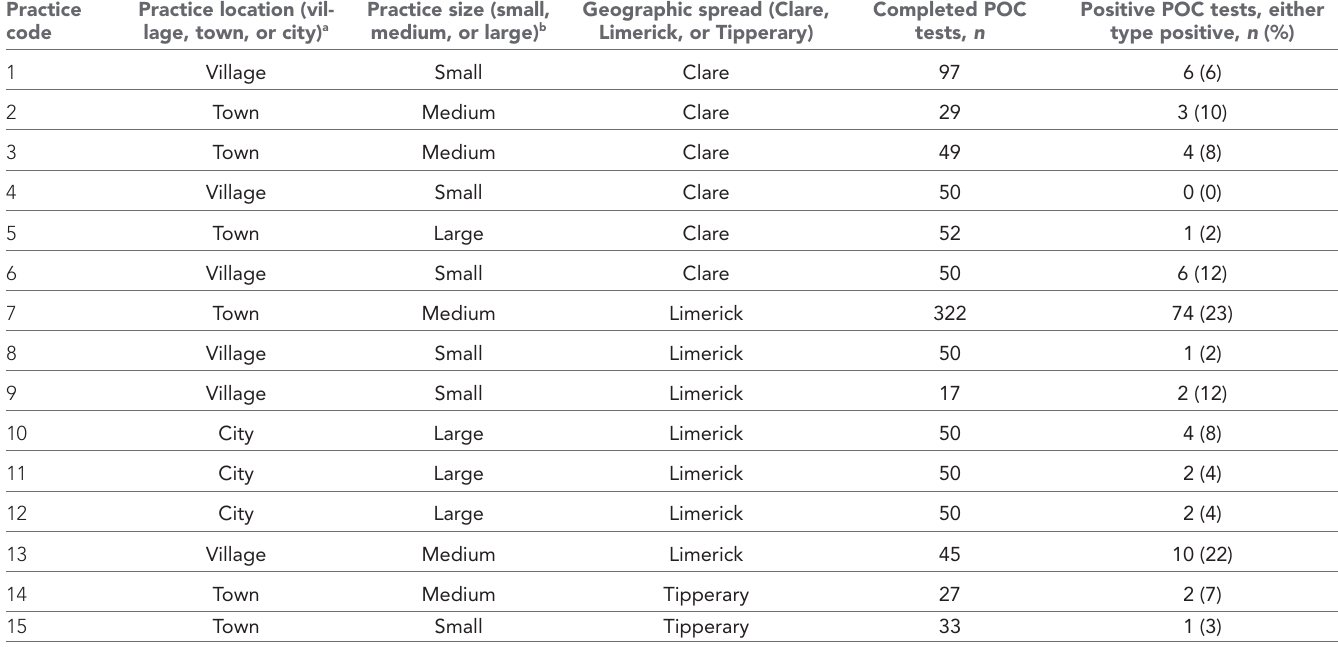
Table 1 Characteristics of participating practices Practice Practice location (vil- code lage, town, or city)